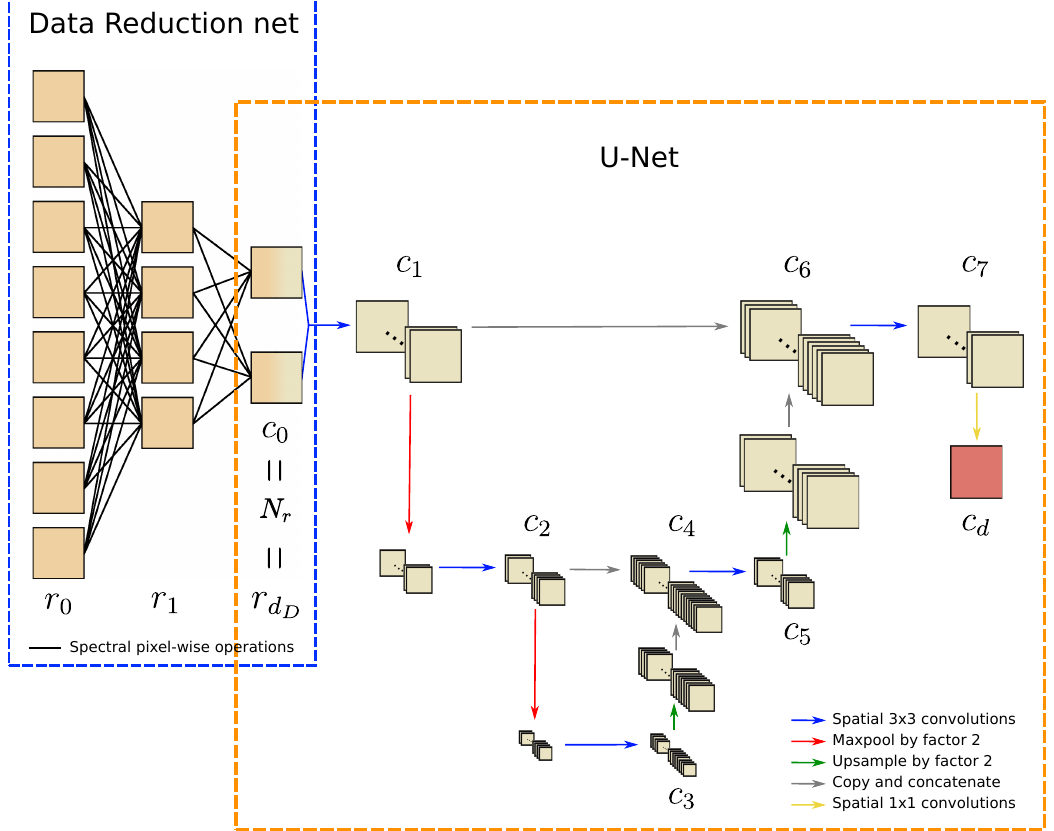
Figure 5. Example of a Data Reduction U-Net structure. The number of channels are indicated with the feature maps. The data are reduced from r 0 = 8 input images to r d map channels in the data reduction net. Each 3 × 3 convolution is followed by a ReLU operation. The number of channels is shown after each convolution and concatenation operations. The network is designed to have c 1 = c 7 , c 2 = c 5 = 2 c 1 , c 3 = 4 c 1 , c 4 = 6 c 1 and c 6 = 3 c 1 . The value of c d is equal to the number of segmentation classes |C|